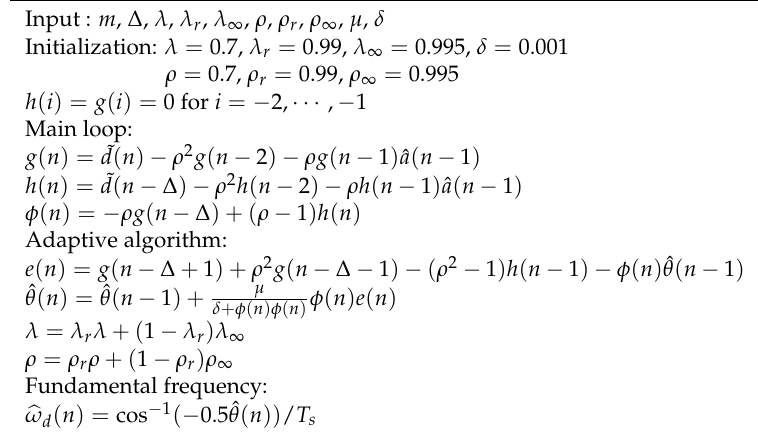
Table 1. Frequency estimation based on SM-ANF method